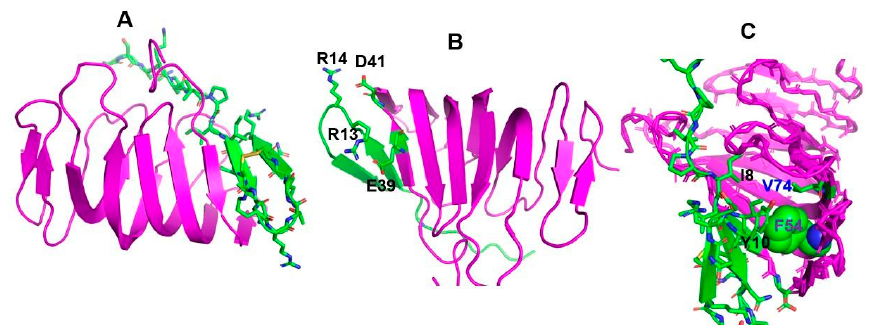
Figure 4. Structure (pdb: 6GD5) of thanatin in complex with LptA m : ( A ) The 3-D topology of the complex showing the β - sheet jelly-roll fold (purple) of LptA m and the β -hairpin of thanatin (in green). The side chains of residues of thanatin are shown as sticks. ( B ) Potential ionic interactions of residues R13 and R14 of thanatin with residues E39 and D41 of LptA m . ( C ) Packing interactions of residues Y10, I8 of thanatin with hydrophobic-pocket residues F54 and V70 of LptA m